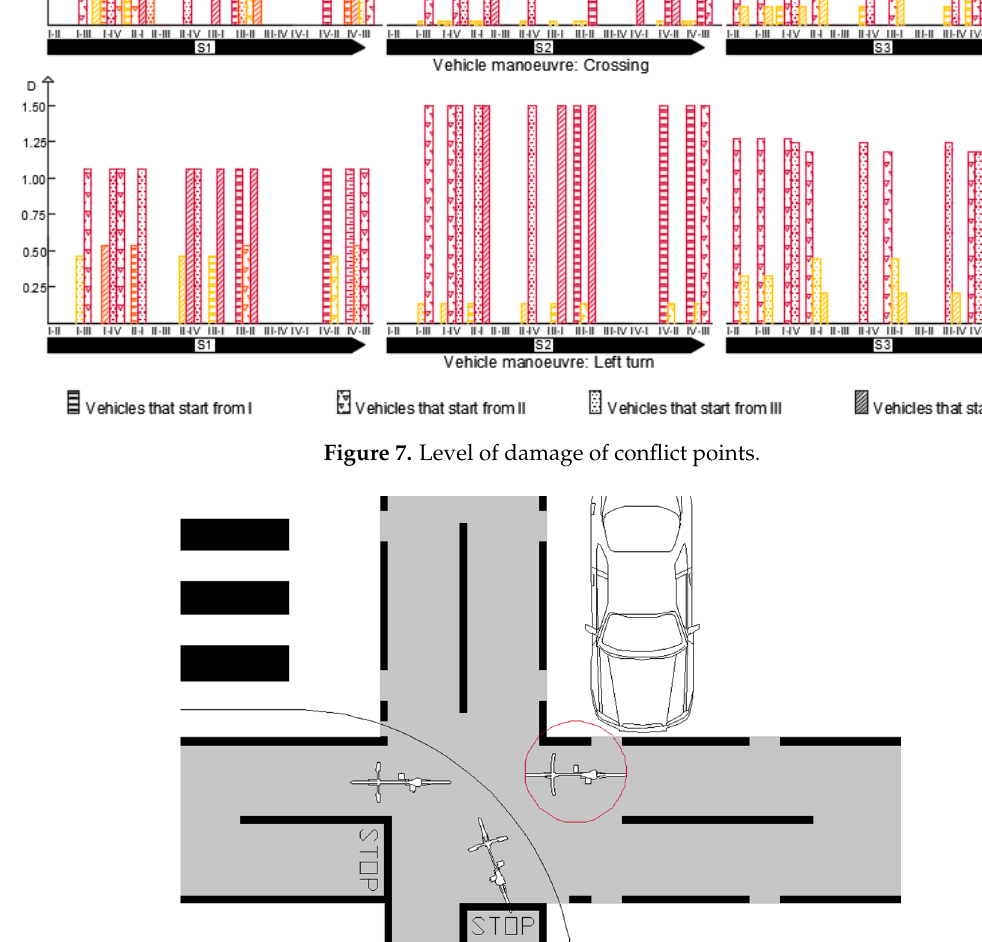
Table 4. Risk assessment of S1, S2, and S3.